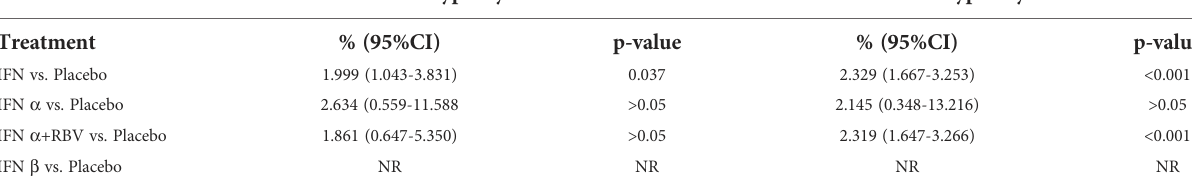
TABLE 2 Summary of relative risk for endocrine adverse events.